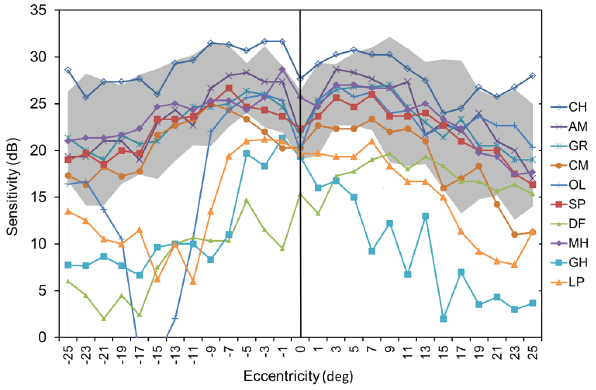
Figure 2. Data from individuals with strabismic amblyopia in binocular viewing (both eyes open and potentially able to detect the blue stimulus and non-dominant eye in its habitual, deviated position) compared with the range of sensitivities found in the equivalent viewing condition in the visually normal controls (denoted by the shaded zone). ‘Sensitivity’ (y- axis) refers to the ability to detect the blue stimulus against the yellow background. Sensitivity is measured in decibels (dB) and, consistent with standard, white-on-white perimetry, a higher sensitivity indicates better performance. Error bars represent 6 1 standard deviation of the mean. Clinical details for strabismic amblyopes are provided in Table 1.